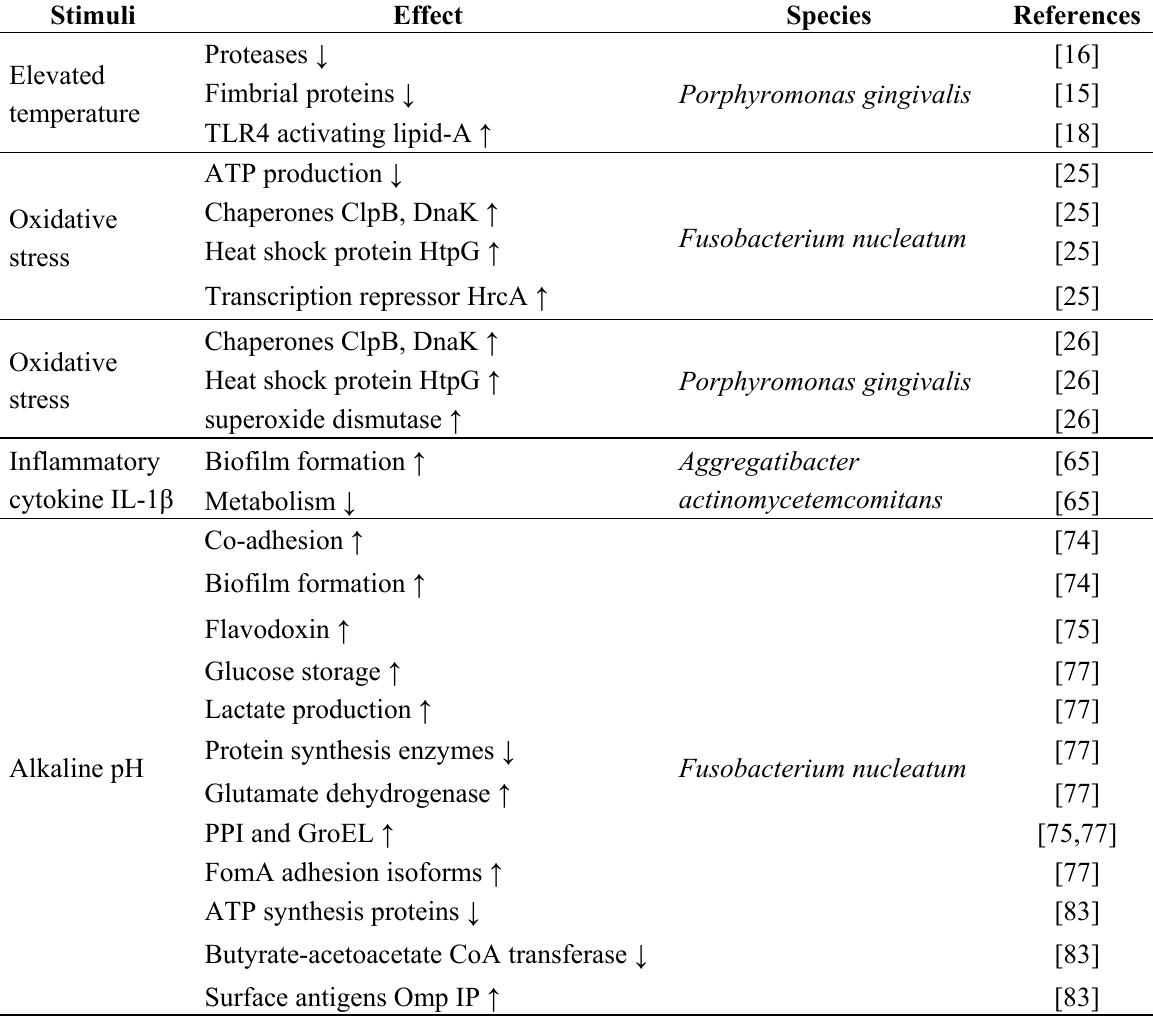
Table 1. Environmental stimuli affecting periodontal biofilm and bacterial virulence